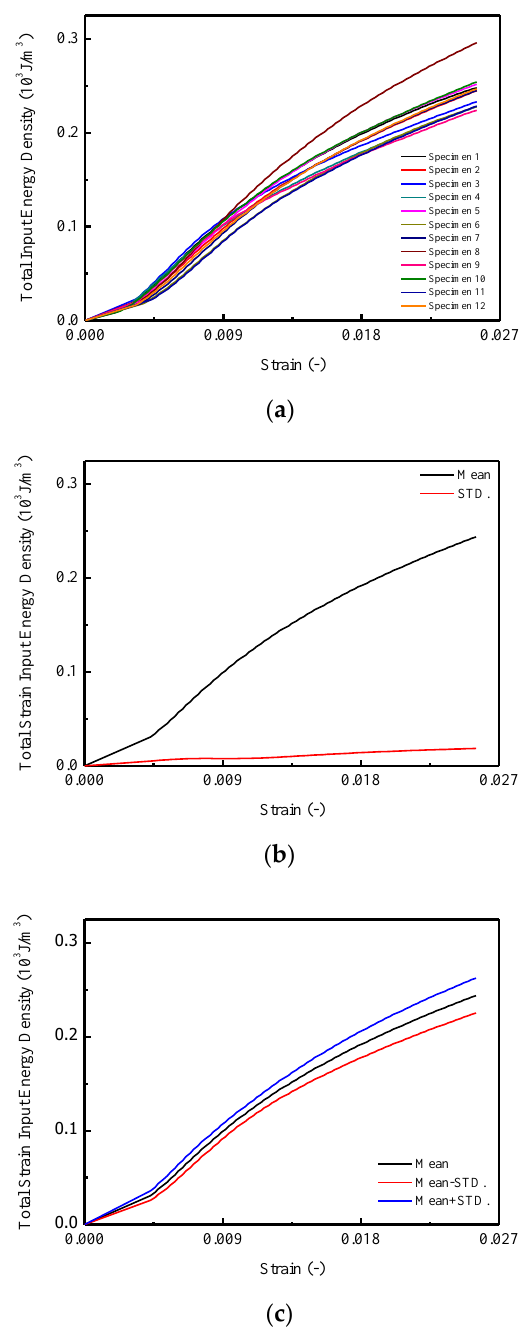
Figure 7. Total input strain energy of CA mortar specimens: ( a ) Total input strain energy of CA mortar specimens; ( b ) Mean and STD of total input strain energy; ( c ) Mean ± STD of total input energy.